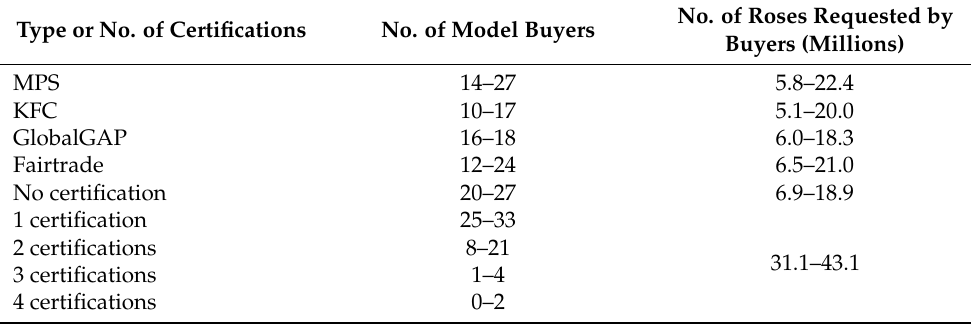
Table 1. Certifications, number of buyers, and number of requested roses. Minimum and maximum in 50 model